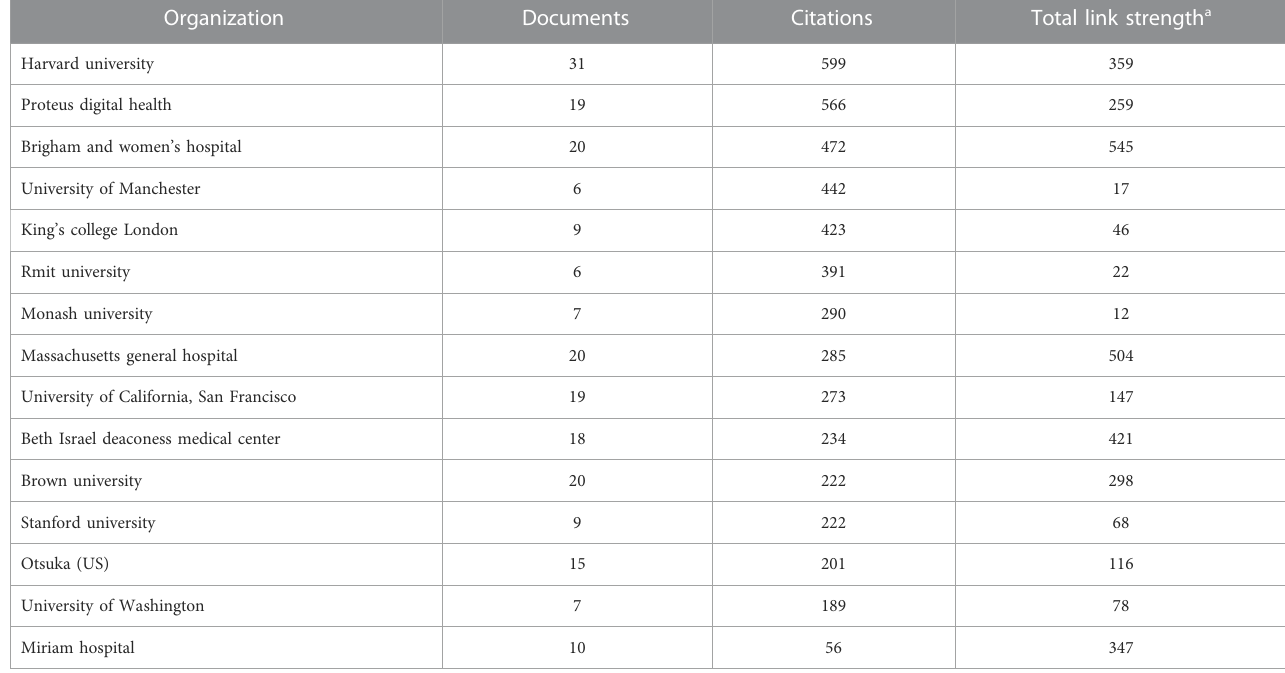
TABLE 1 The top leading organizations in publishing and scienti fi c activity in the fi eld of digital pills for the period January 2012 to July 2022. Organization